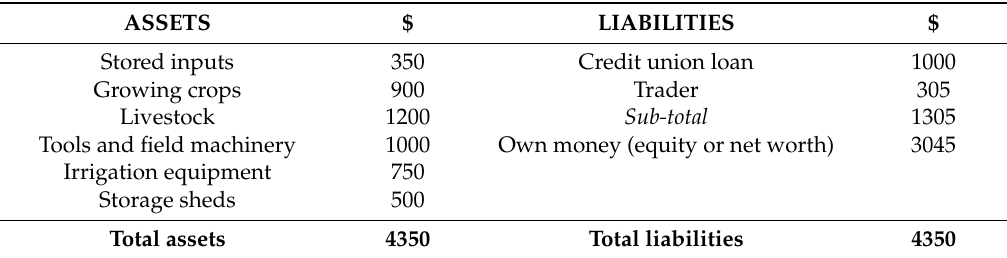
Table 6. Balance sheet